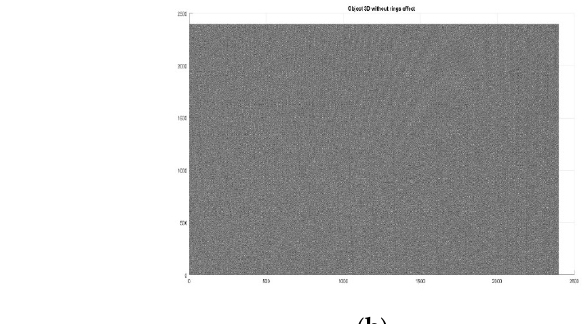
Figure 8. Measurement results of a flat plate: ( a ) 3D shape measurement results with impact of black circle ring (typical rings circled); and ( b ) 3D shape measurement results with the proposed method.